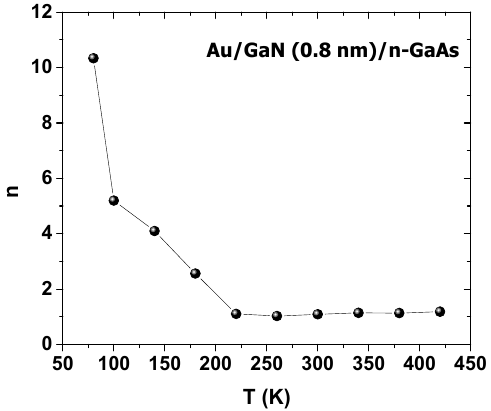
Figure 9. R s (Cheung and Cheung method) versus temperature.